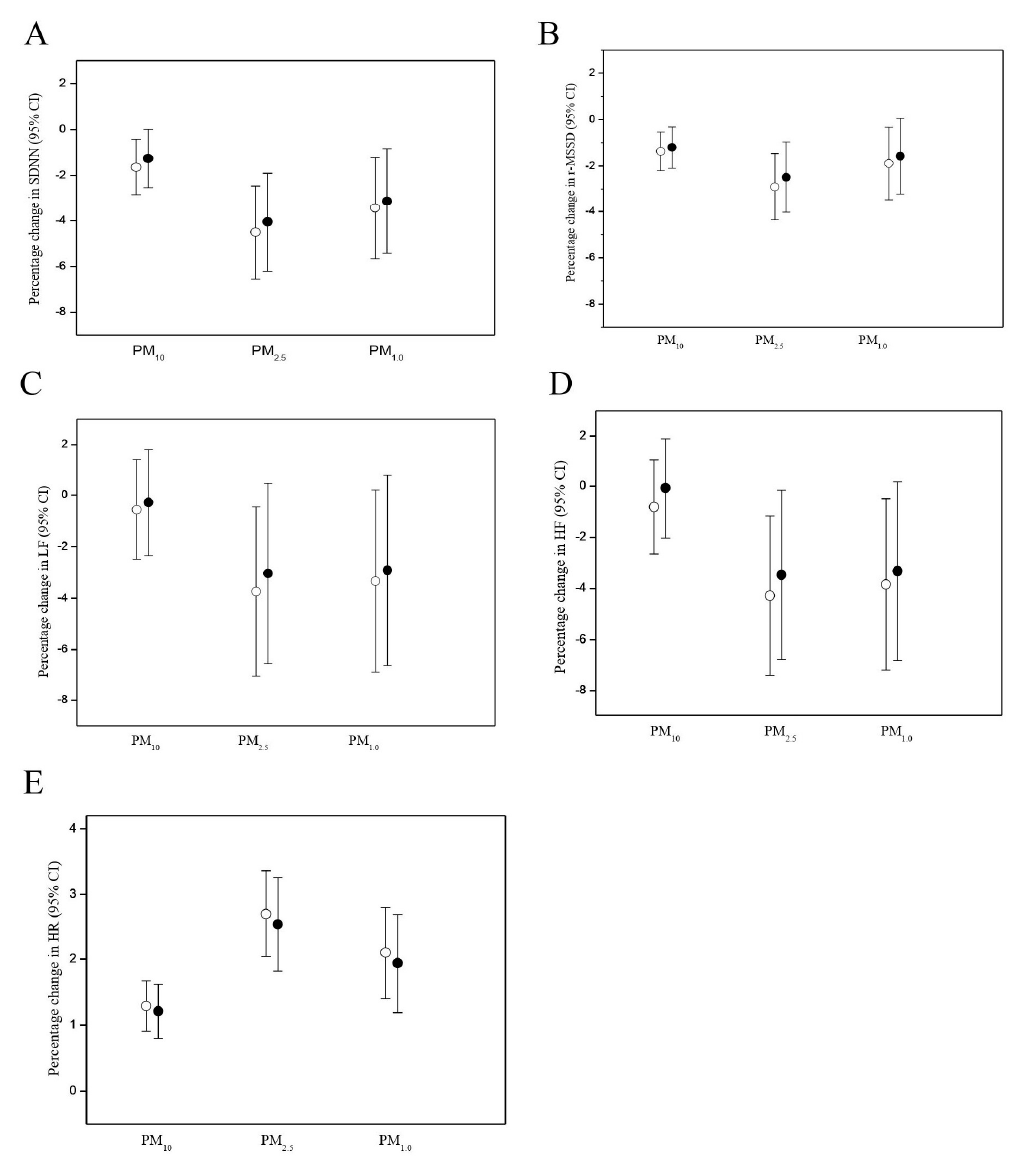
Figure 2. Comparisons of effects of 1-h moving average PM exposure on heart rate variability (HRV) and heart rate (HR) among 54 workers with (solid circles) and without (open circles) adjustment of urinary 8-OHdG levels as estimated using linear mixed effects models. ( A ) Effects of 1-h moving average PM exposure on SDNN with and without adjustment of urinary 8-OHdG levels, ( B ) Effects of 1-h moving average PM exposure on r-MSDD with and without adjustment of urinary 8-OHdG levels, ( C ) Effects of 1-h moving average PM exposure on LF with and without adjustment of urinary 8-OHdG levels, ( D ) Effects of 1-h moving average PM exposure on HF with and without adjustment of urinary 8-OHdG levels, ( E ) Effects of 1-h moving average PM exposure on HR with and without adjustment of urinary 8-OHdG levels. Models were adjusted for age, BMI, smoking, years as a cook, and ambient